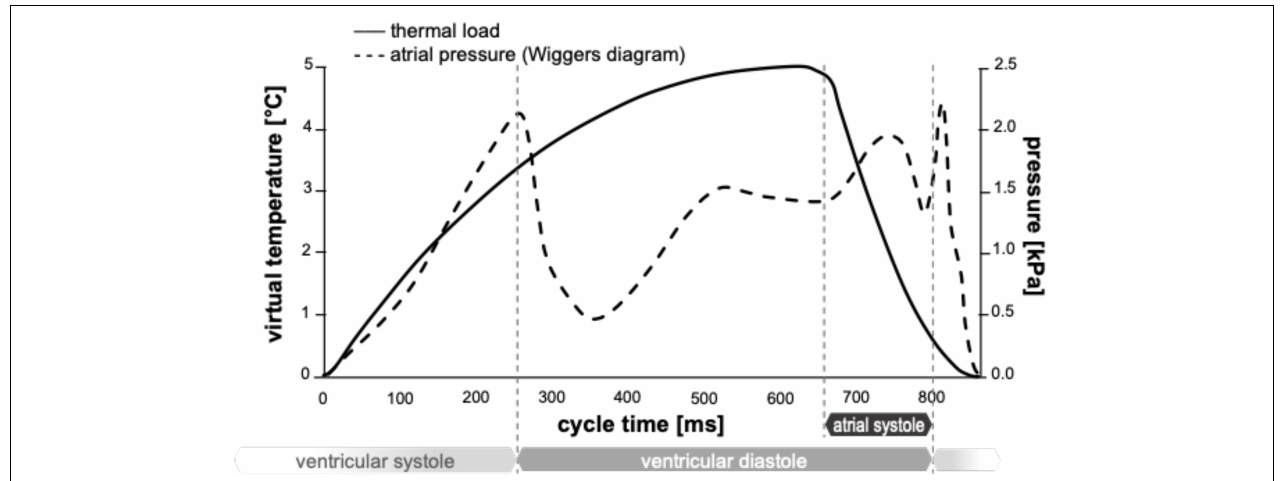
FIGURE 4 | Thermal load (continuous line) and physiological atrial pressure curve (dashed